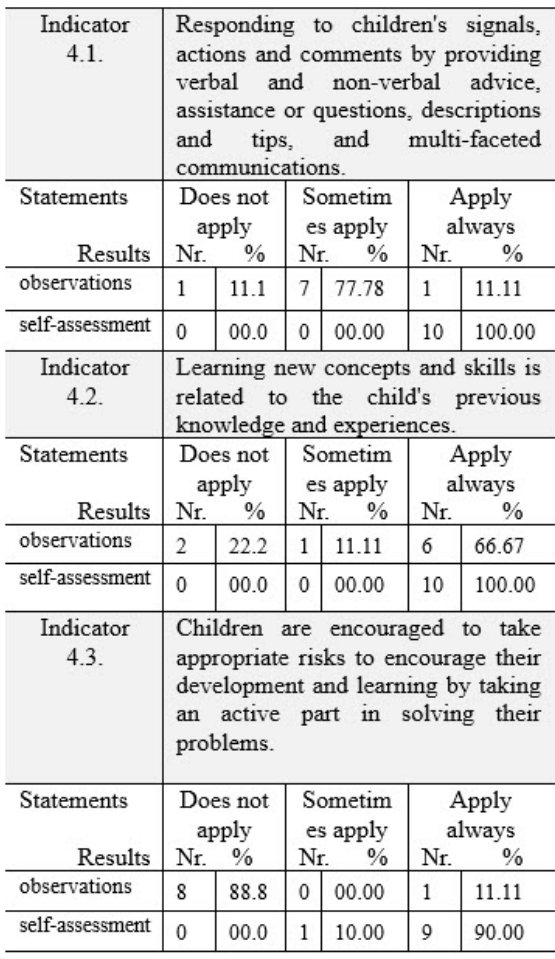
Table 21. Principle 4: Development and learning is promoted through